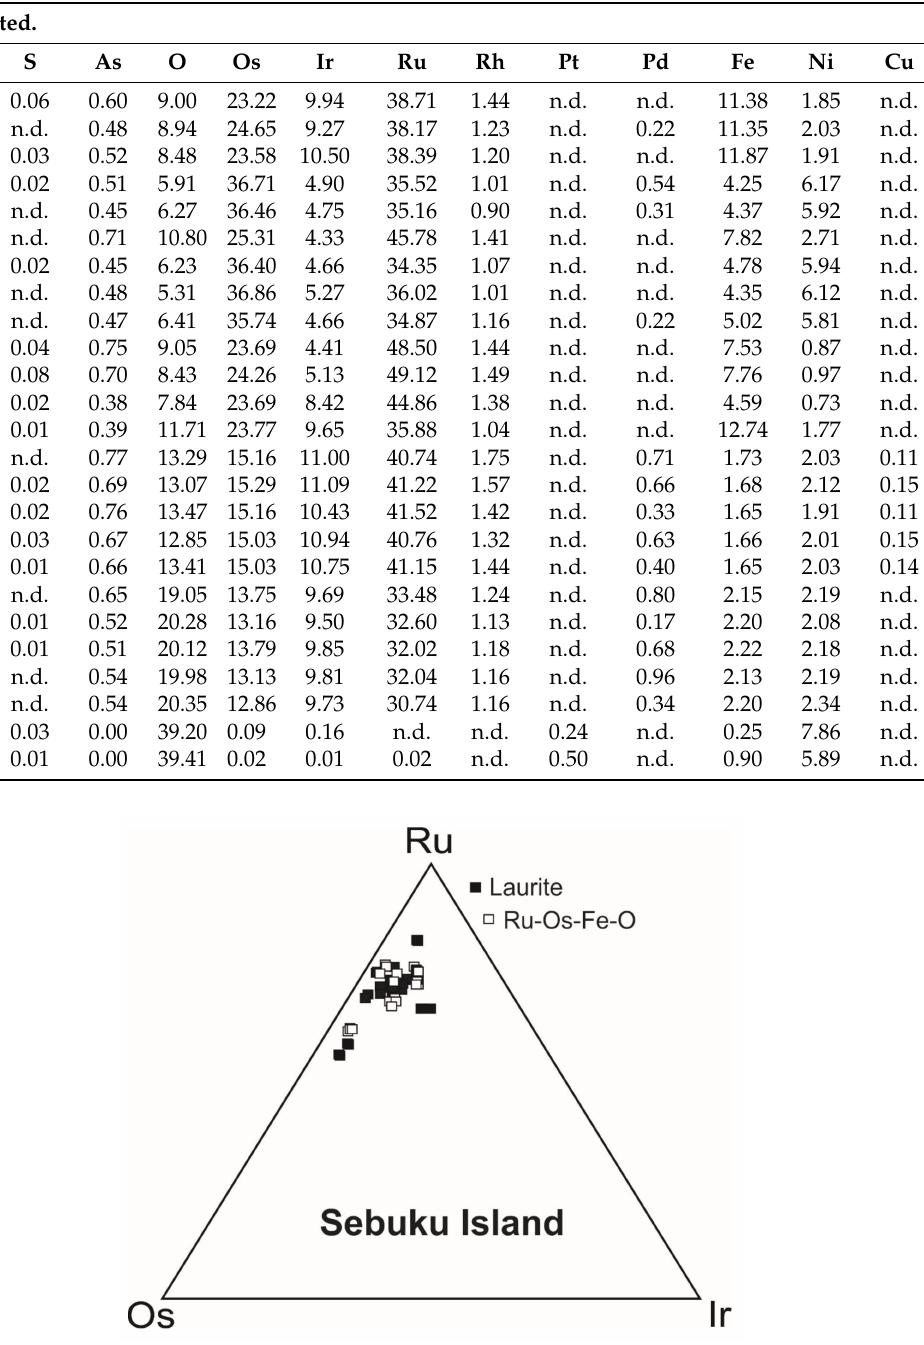
Figure 13. Ru-Os-Ir ternary diagram of the compositions (atomic %) of laurite and Ru-Os-Ir-Fe oxygenated compounds from Sebuku